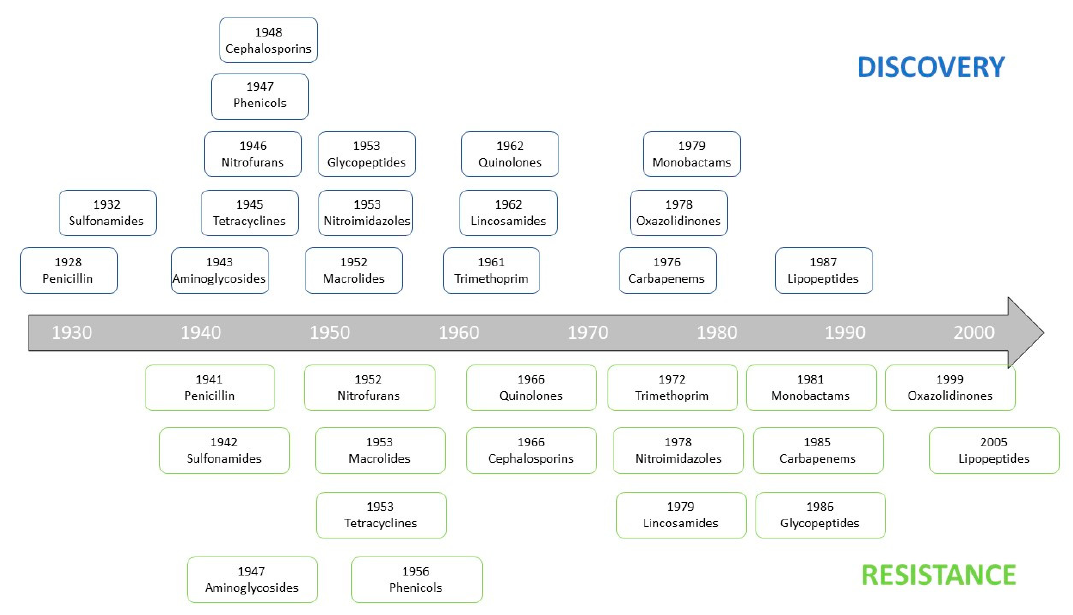
Figure 3. Antibiotics timeline from the end of the 1920s until today, indicating when the main antibiotic classes were discovered, and when the mechanisms of resistance to these antibiotics were first described.